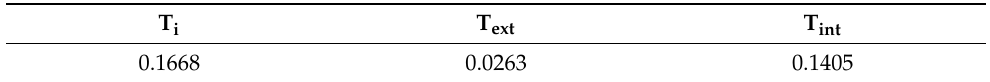
Table 3. Total intragroup and intergroup variability of the accessibility of PHC facilities calculated using the Theil